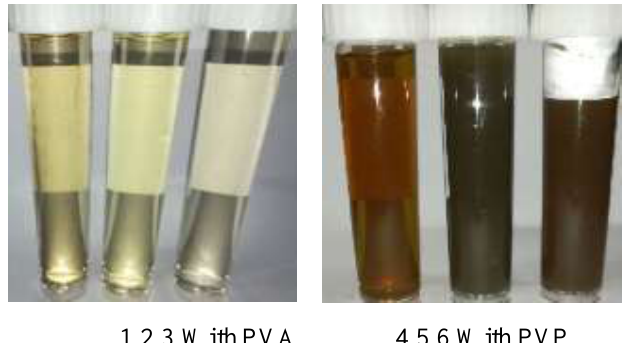
Figure 3: Silver particles after adding the fixing